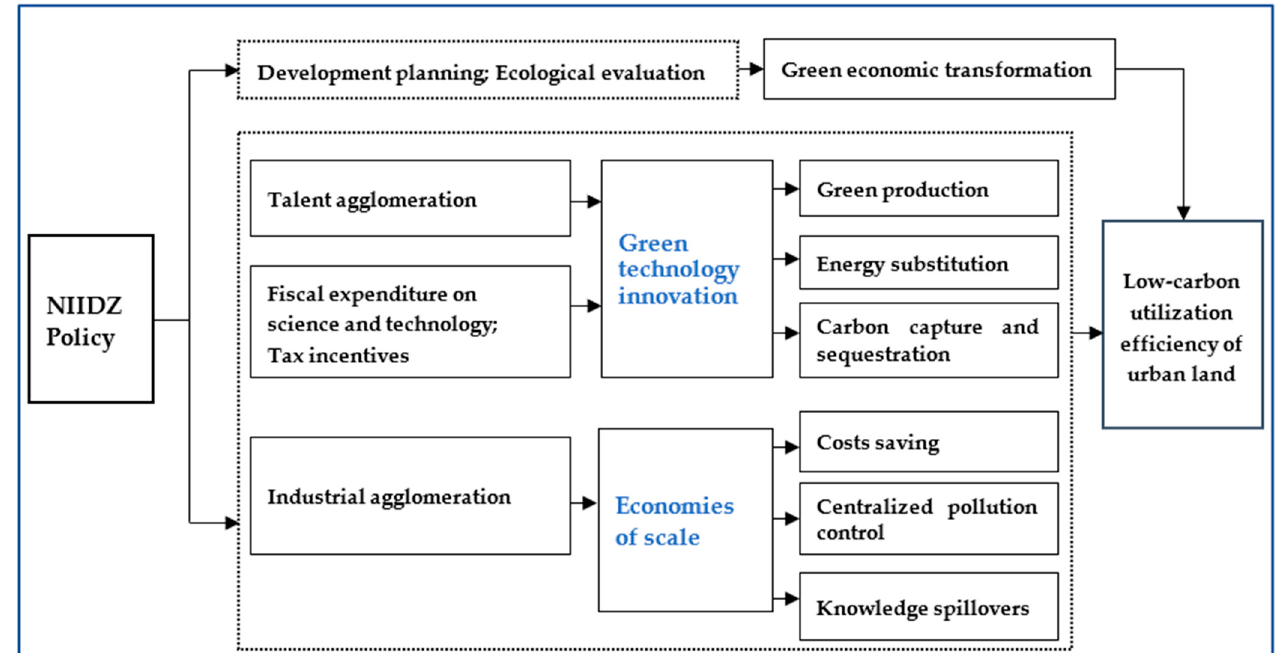
Figure 2. The influencing mechanisms.